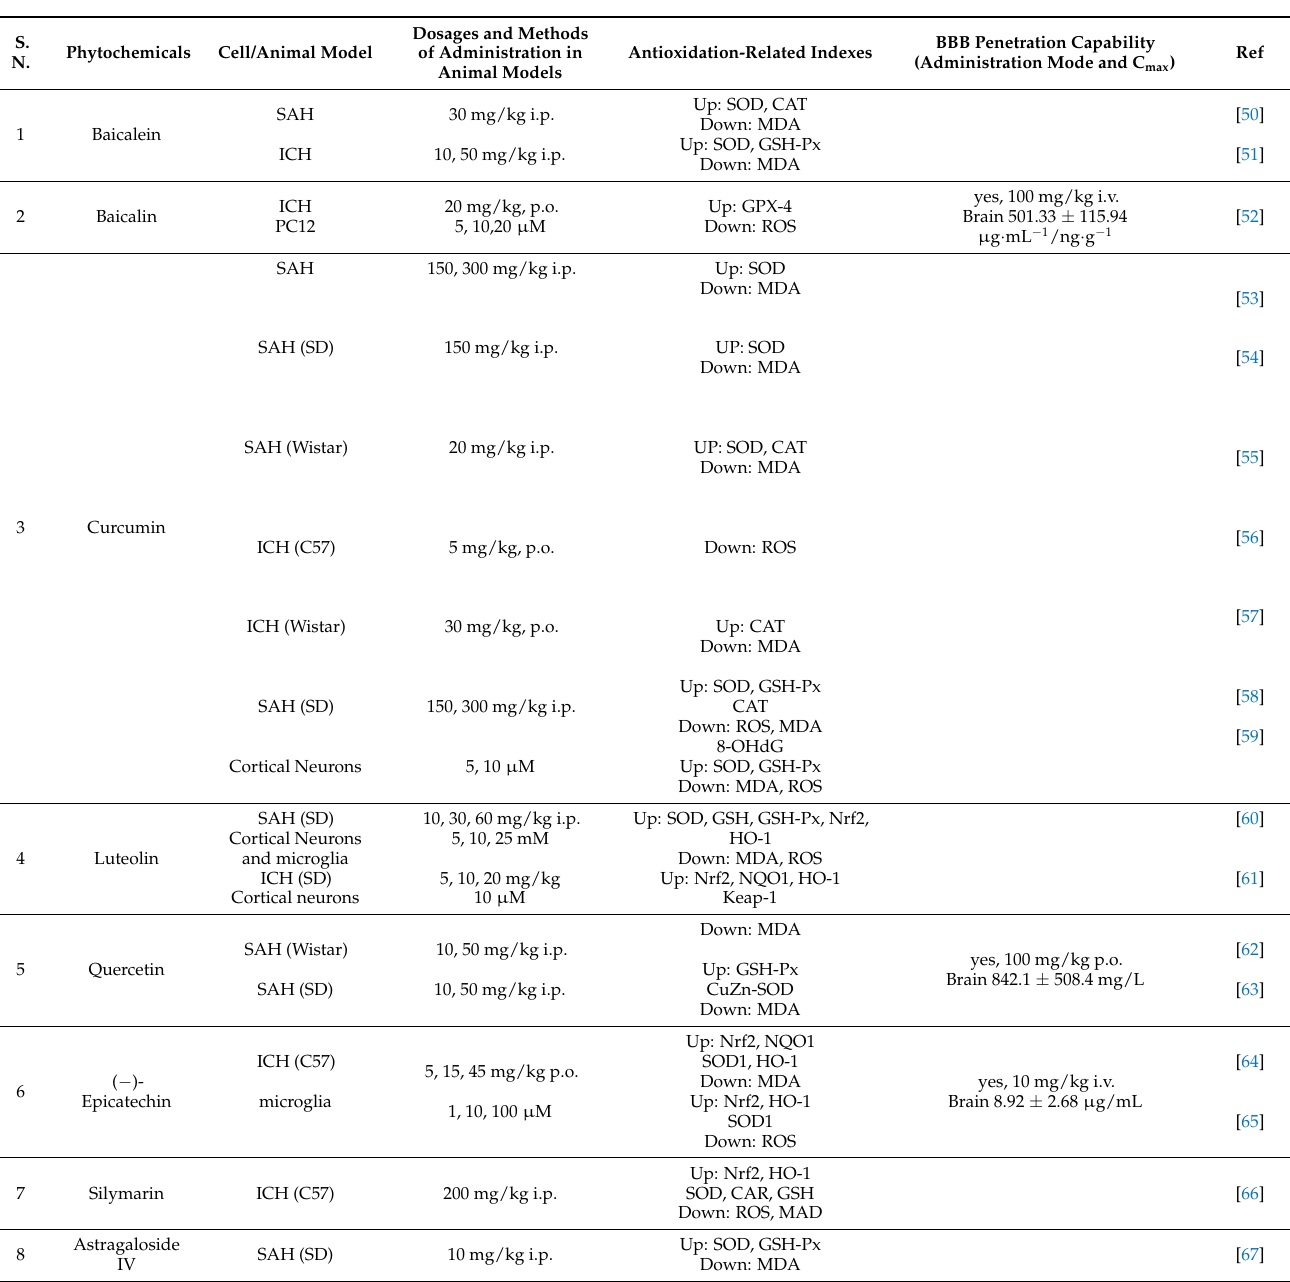
Table 1. Antioxidant activity of nature product in ICH related